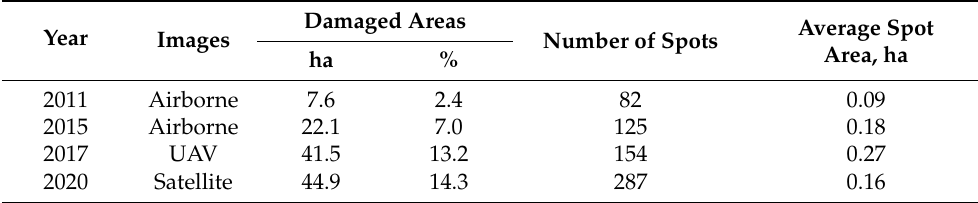
Table 1. Dynamics of Norway spruce stands destroyed by I. typographus in captured areas (314.0 ha) in the Chuprene Reserve.